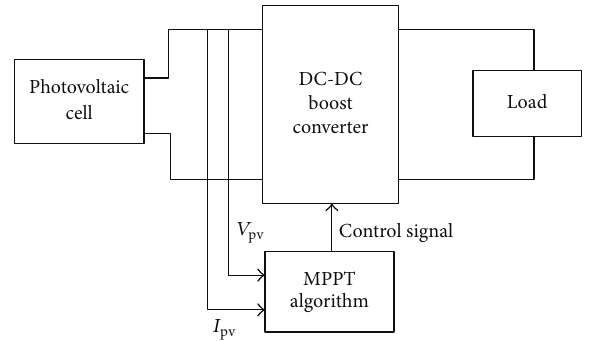
Figure 4: Structure diagram of photovoltaic power